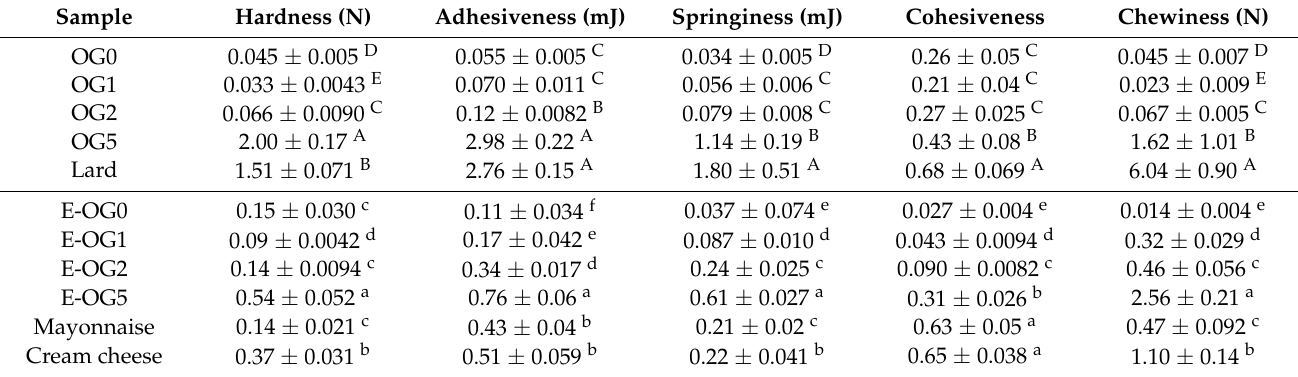
Different uppercase and lowercase letters represent significant differences of oleogels and emulsions, respectively. ( n = 5, p < 0.05) .